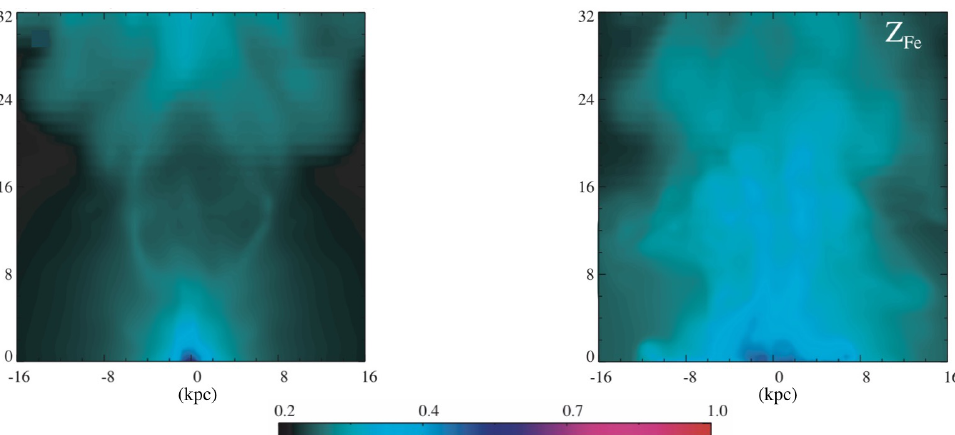
Figure 11. The iron abundance projected maps can differentiate between different models of AGN feeding triggering and self-regulation, here in a common HR HD simulation of a massive galaxy group (adapted from Gaspari et al. [214]). ( Left ) CCA feeding mode, driving intermittent and frequent AGN features, such as cavities with metal-rich rims and trailing filaments. ( Right ) Bondi feeding mode, driving a perennial, wide monolithic cylinder of metals into the group core (with no bubbles or